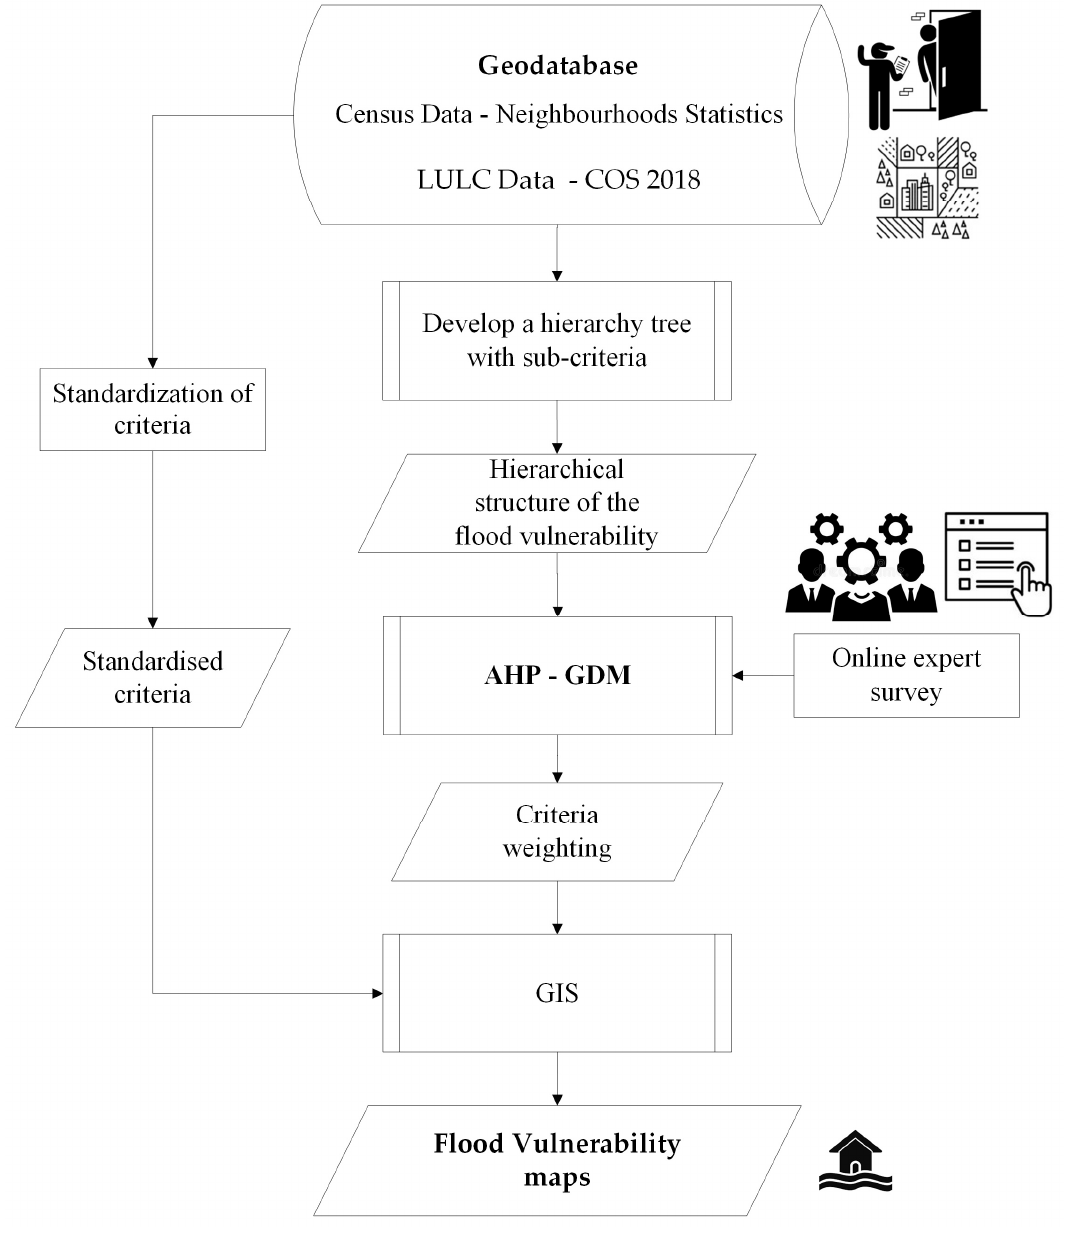
Appl. Sci. 2023 , 13 , x FOR PEER REVIEW Figure 2. Methodology fl owchart. Figure 2. Methodology flowchart.